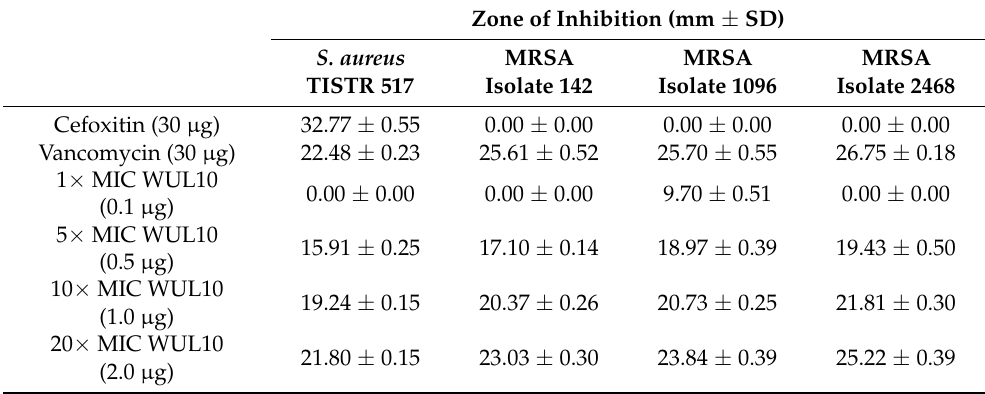
Table 4. Agar well-diffusion method to determine the potency of pure substance from WUL10 and antibiotics (means ± SD; n =